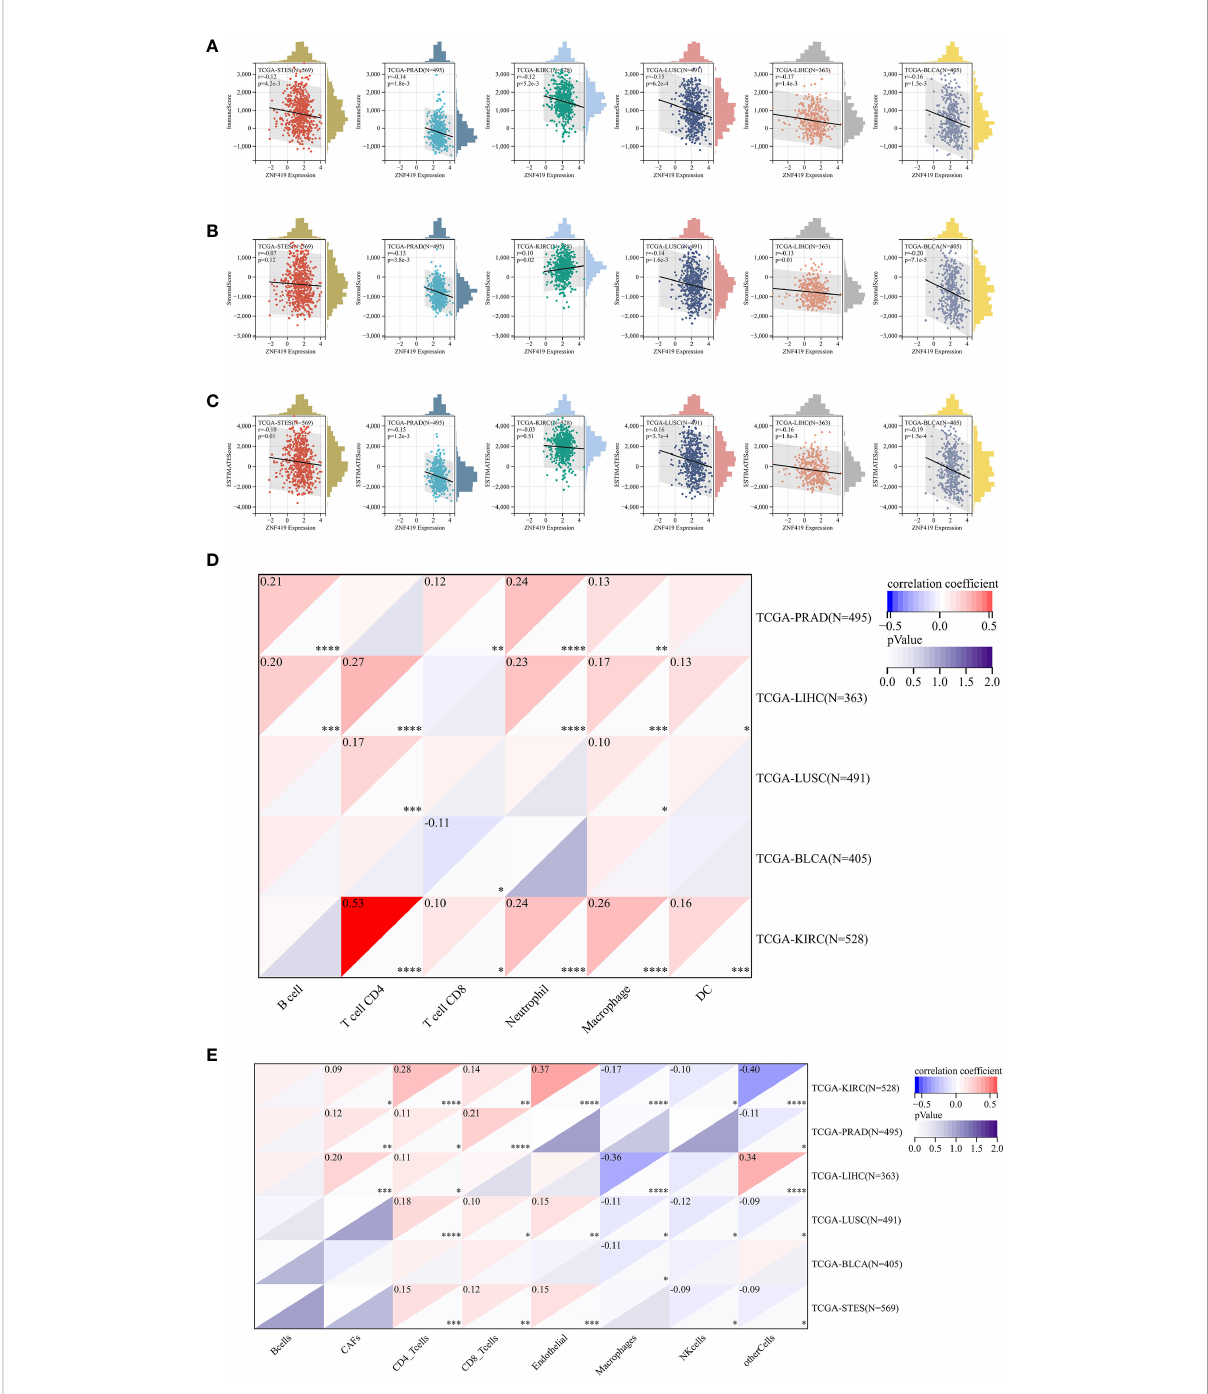
FIGURE 5 Tumor immune environment and its correlation with ZNF419 expression. (A) the correlation of ZNF419 expression with immune score; (B) the correlation of ZNF419 expression with stromal score; (C) the correlation of ZNF419 expression with estimate score; (D) the correlation of ZNF419 expression with immune in fi ltrating cells using TIMER; (E) the correlation of ZNF419 expression with immune in fi ltrating cells using EPIC. DC, dendritic cells. "*, **, ***, ****" corresponds to the p value "<0.05, <0.01, <0.001,